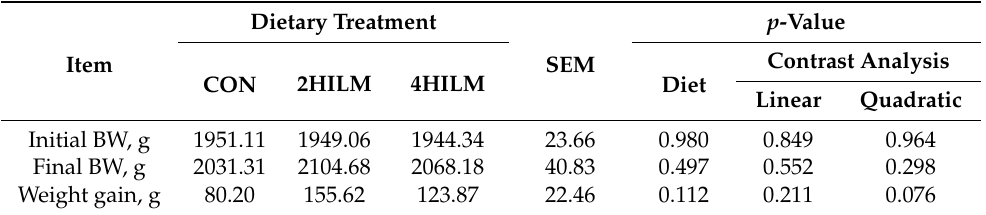
Table 2. Changes in body weight (BW) of laying hens during the trial ( n = 8 cages/treatment).